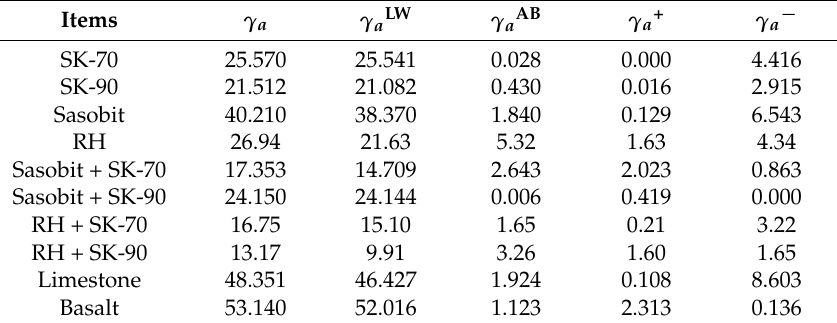
Table 2. Surface free energy components of raw materials (mJ/m 2